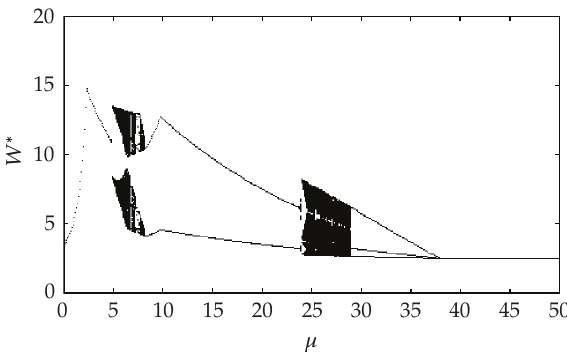
Figure 6: Bifurcation diagram with respect to μ